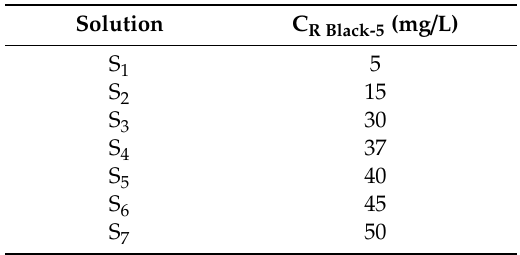
Table 1. Concentrations of Reactive Black -5 solutions.